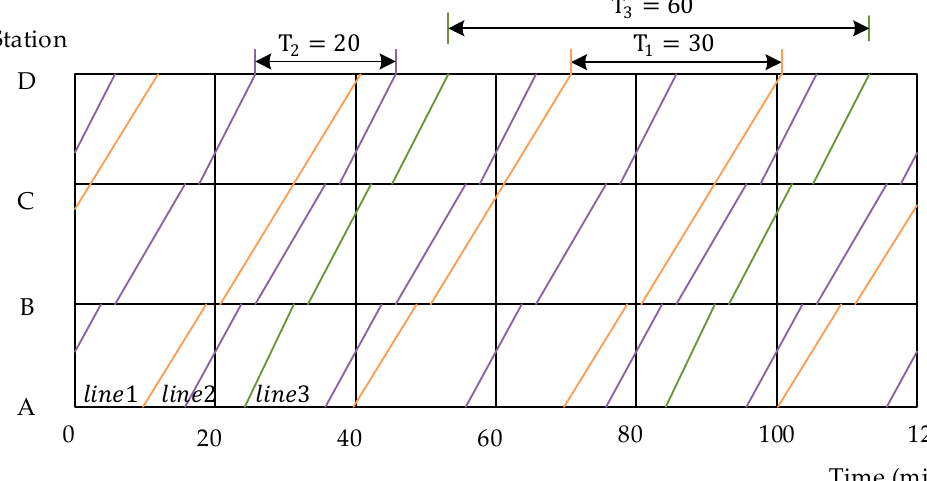
Figure 1. A multi-cycle train timetable with three-cycle period. There are 3 train lines. The cycle length of line 1 is 30 min, and the train belonging to line 1 departs every 30 min. The cycle length of line 2 is 20 min, and the train belonging to line 2 departs every 20 min. The cycle length of line 3 is 60 min, and trains belonging to line 3 depart every 60 min.